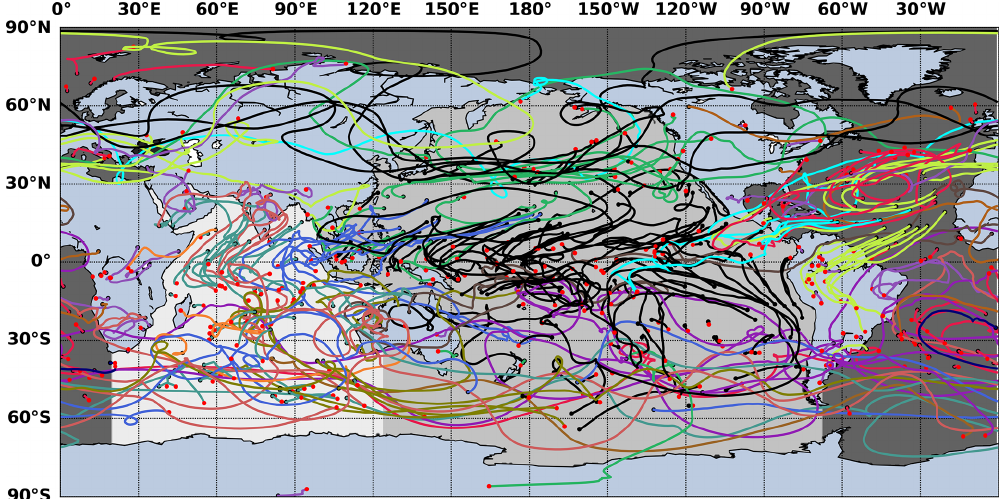
Figure 1. Spaghetti plot of few selected atmospheric water trajectories for the month of January 2016. The selected ocean basins are repre- sented by different shadings of gray and defined as the Indian Ocean (IO), Pacific Ocean (PO) and Atlantic Ocean (AO). Note that the Arctic Ocean is included in the Atlantic. The global landmass is taken as one single entity. The atmospheric water transport within and between the ocean basins and land has been calculated based on these defined sectors. The representative trajectories associated with these intra- and inter-basin water transport are labelled with different colours. The black dots indicate the starting points and the red points represent the ending points of the atmospheric water